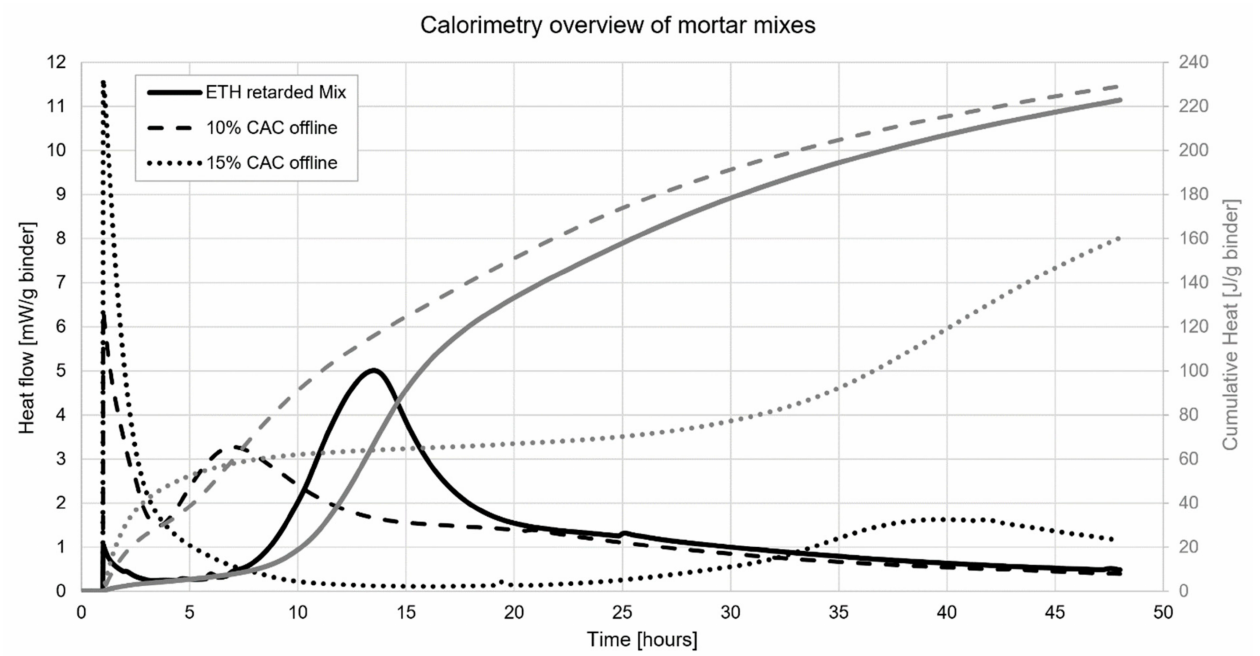
Figure 8. Calorimetry comparison of mortar